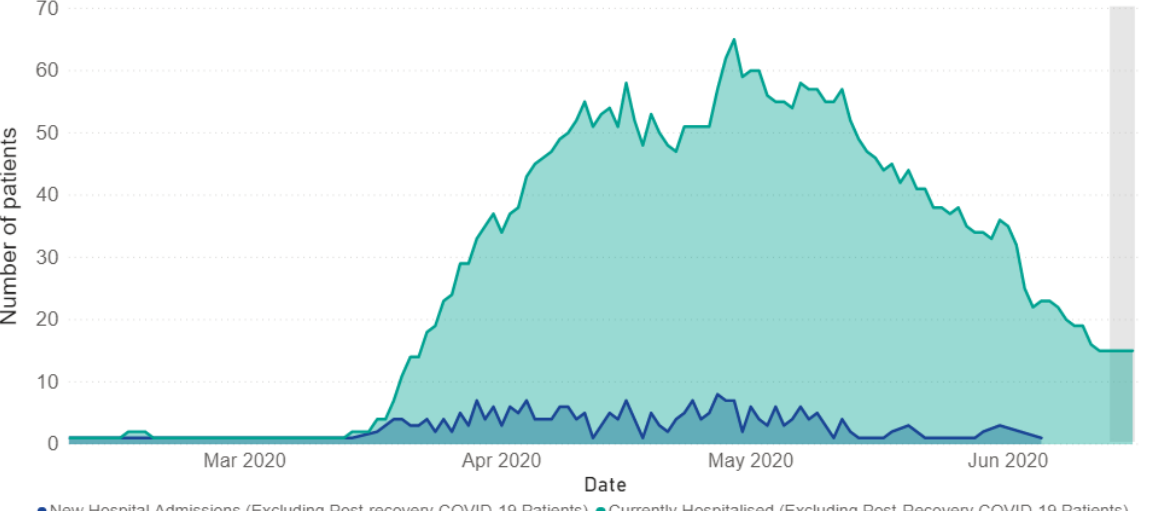
Figure 4. Number of Ottawa residents with confirmed COVID-19 newly admitted to hospital and number currently hospitalized, by